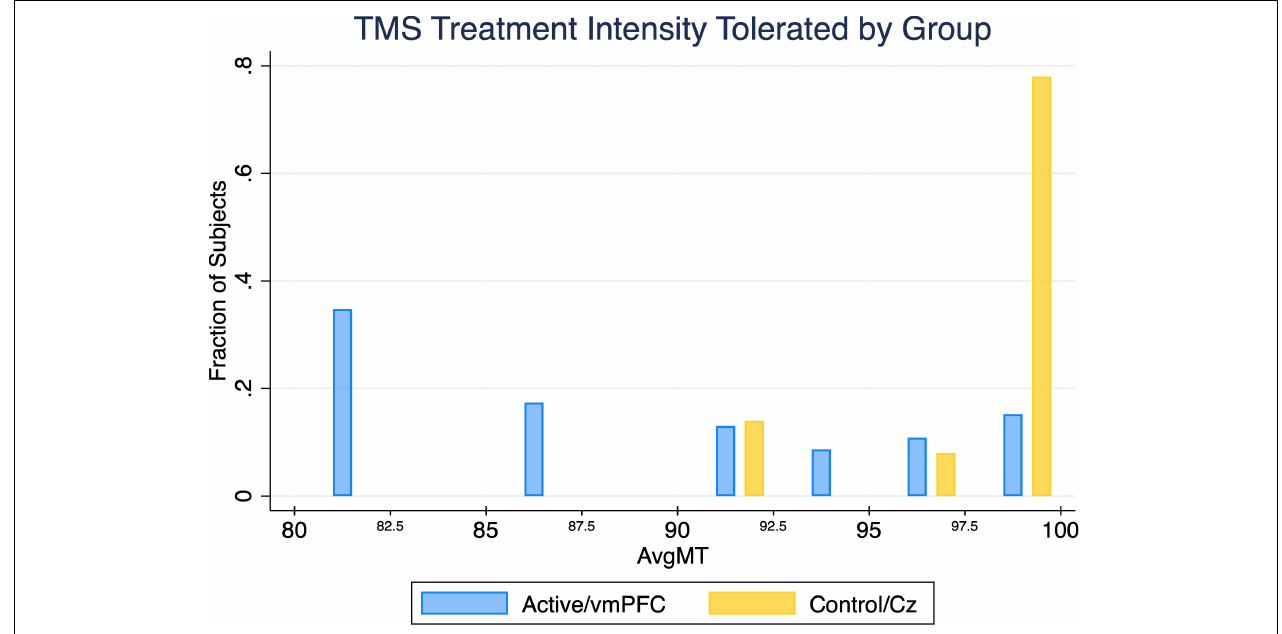
FIGURE 4 | Between-group comparison of average TMS treatment intensity tolerated (noted as a percent of the resting motor threshold). Utilizing a 2-sided Mann–Whitney U Test, we found the maximum TMS intensity tolerated by the active treatment group is significantly lower ( p = 0.027) than the control treatment group by an average of